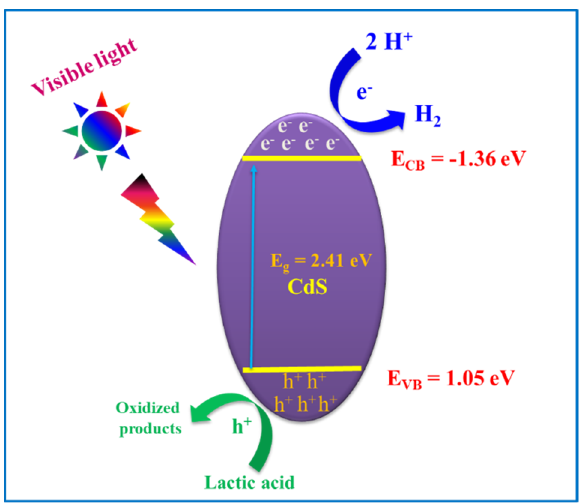
Scheme 2. Visible photocatalytic H 2 evolution mechanism over CdS NR photocatalyst